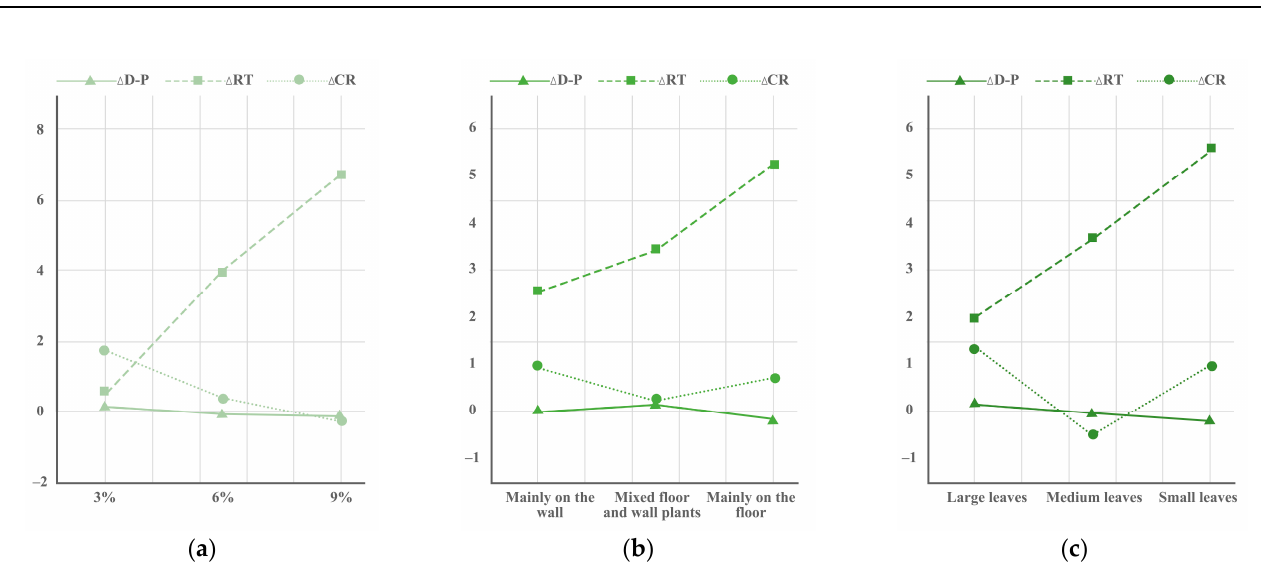
Figure 9. ( a ) Relationships between the volume ratio and attention recovery; ( b ) Relationships between the layout and attention recovery; ( c ) Relationships between the leaf size and attention recovery.